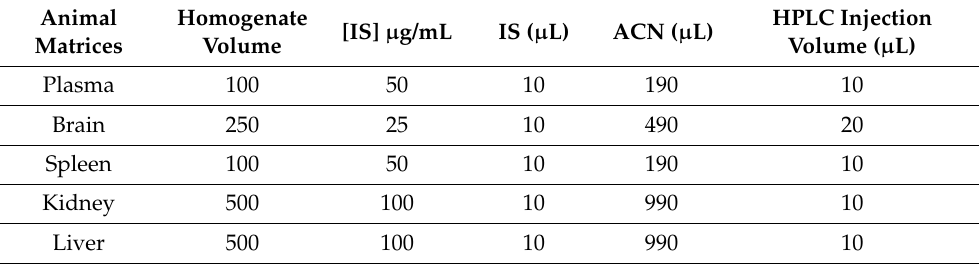
Table 2. Sample preparation